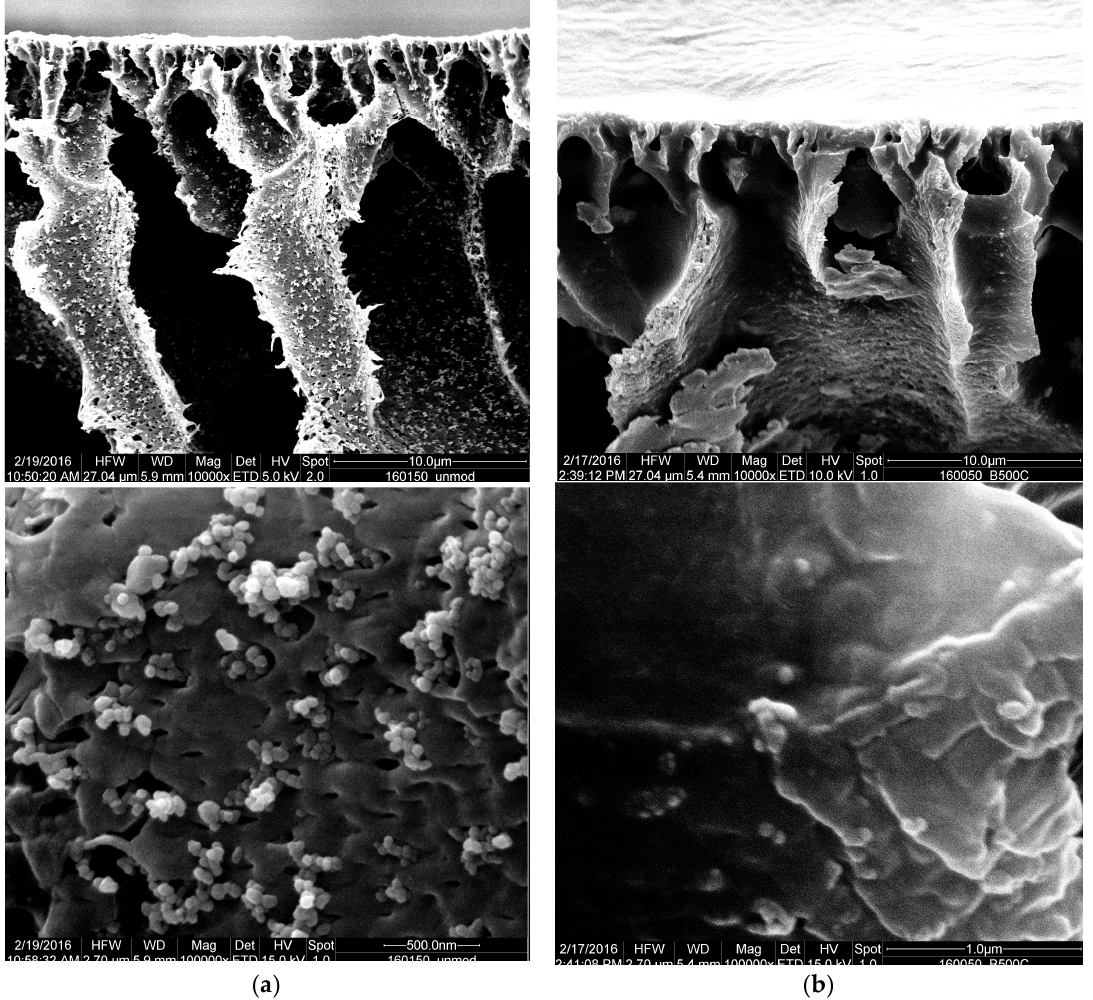
Figure 9. Agglomerates in the cross-section of PVDF nanocomposite membranes prepared with 50% w / w (PVDF) nanoparticles. ( a ) reference with unmodified ZnO and 1% PVP; ( b ) only PVP modified ZnO used. Upper pictures: magnification 10,000×; lower pictures: magnification 100,000×.